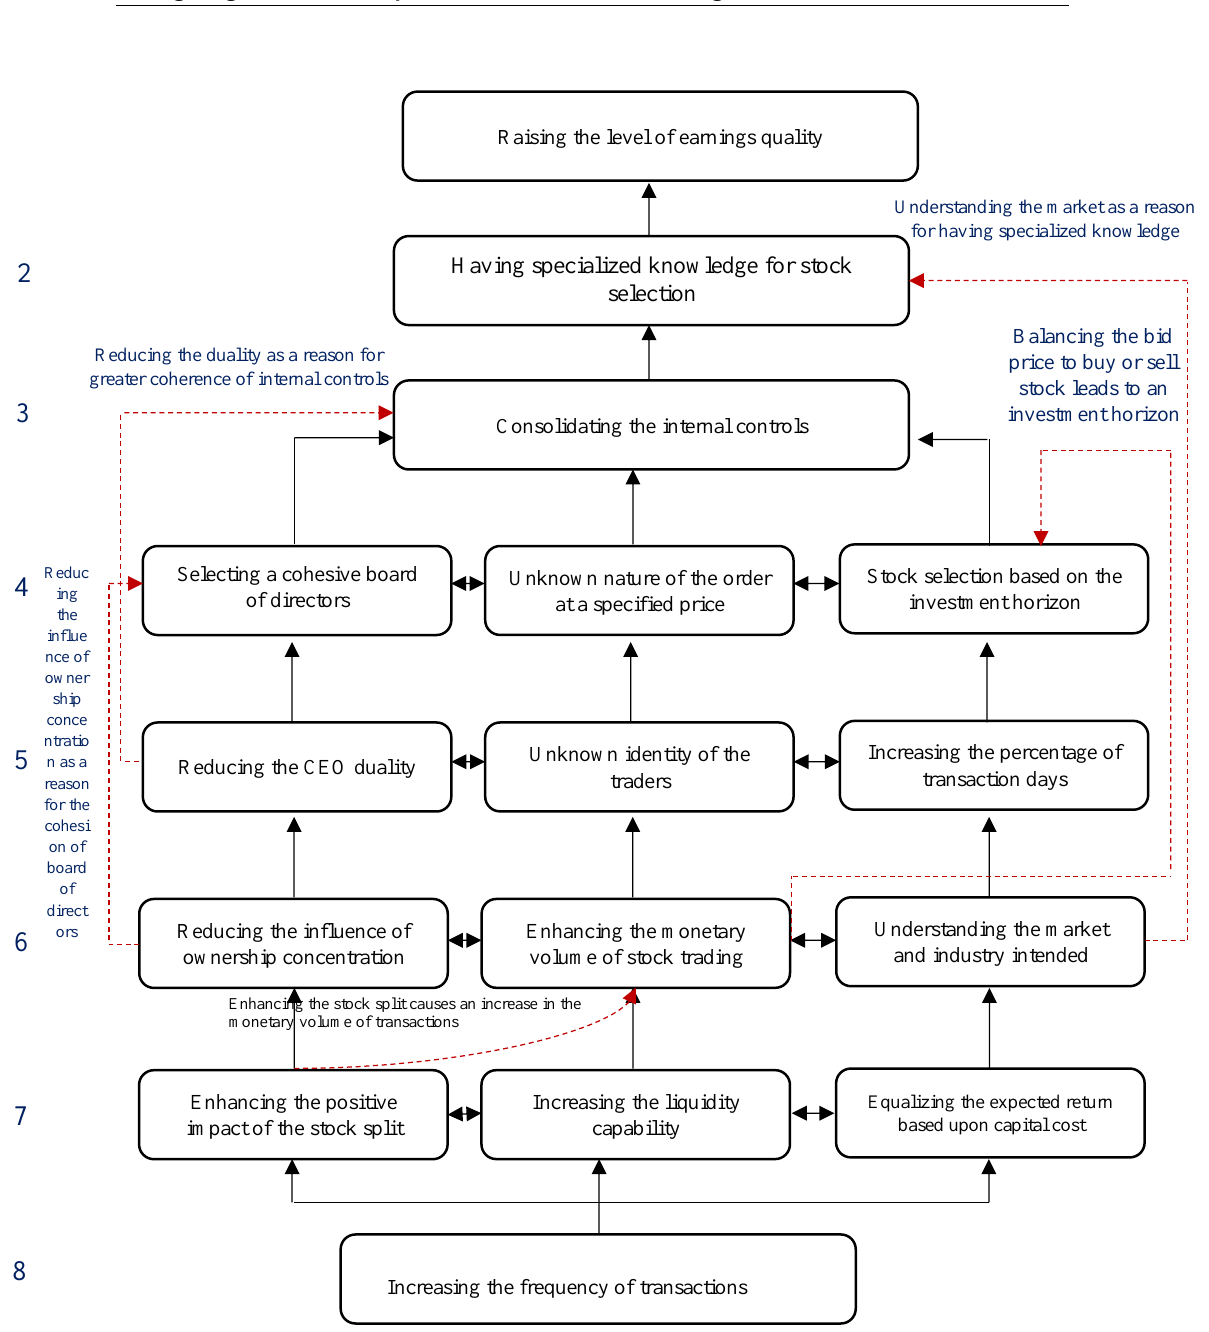
Figure 2. The hierarchical levels of the most effective propositions for stock